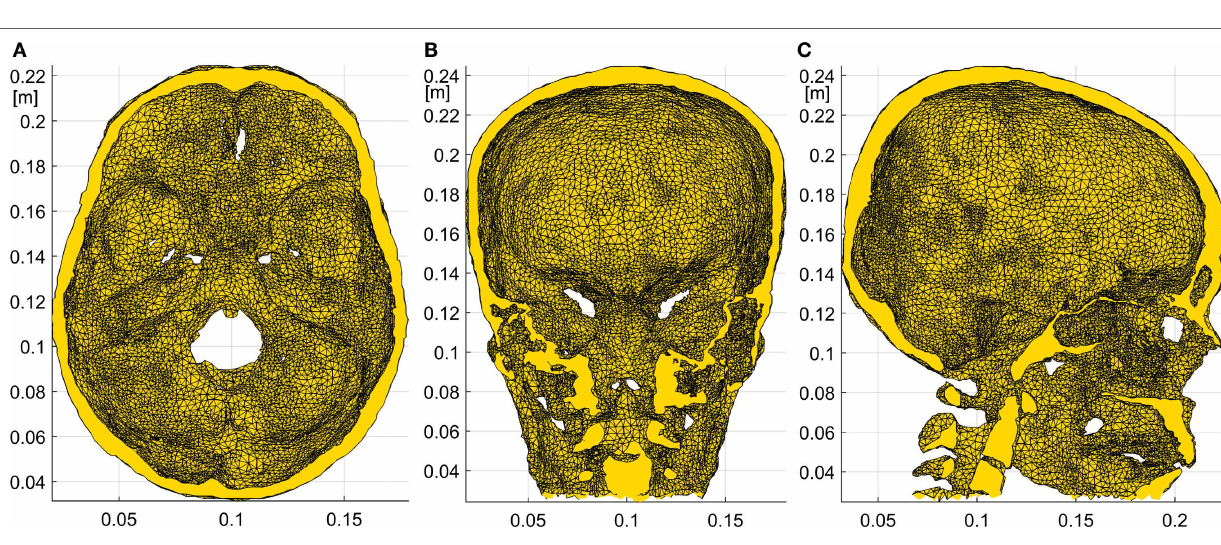
FIGURE 2 | Details of the skull FE model. Axial (A) , coronal (B) , and sagittal (C) slices of the skull obtained from the subject specific CT. The skull base and optic foramina as well as the frontal sinuses and other internal air compartments are clearly